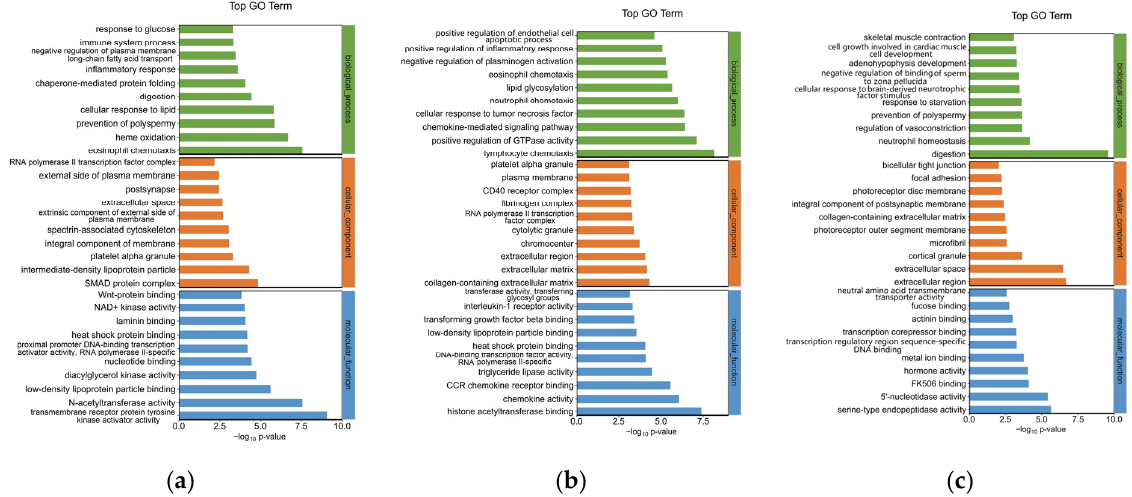
Figure 3. GO functional analysis of differentially expressed genes in spleen tissues of southern catfish. ( a ) Top 30 enriched GO terms of upregulated DEGs between PS and BC groups. ( b ) Top 30 enriched GO terms of downregulated DEGs between L-PS and PS groups. ( c ) Top 30 enriched GO terms of downregulated DEGs between L and BC groups.